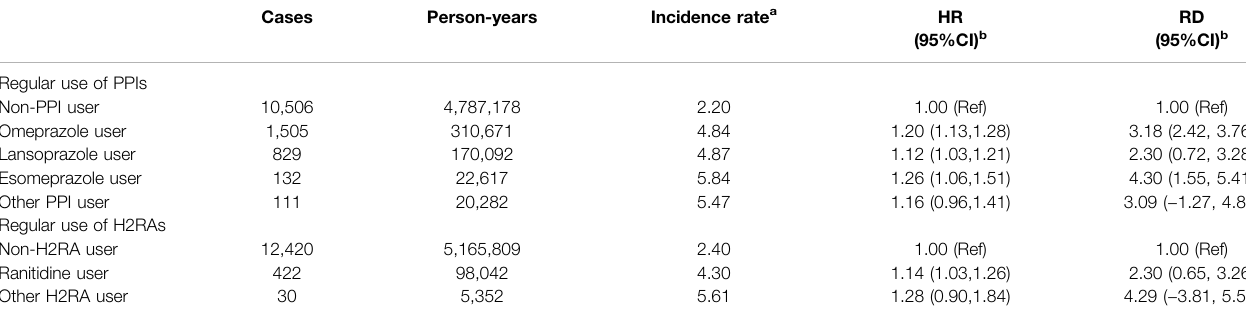
TABLE 3 | The associations between regular use of individual class of PPI/H2RA and risk of cholelithiasis.